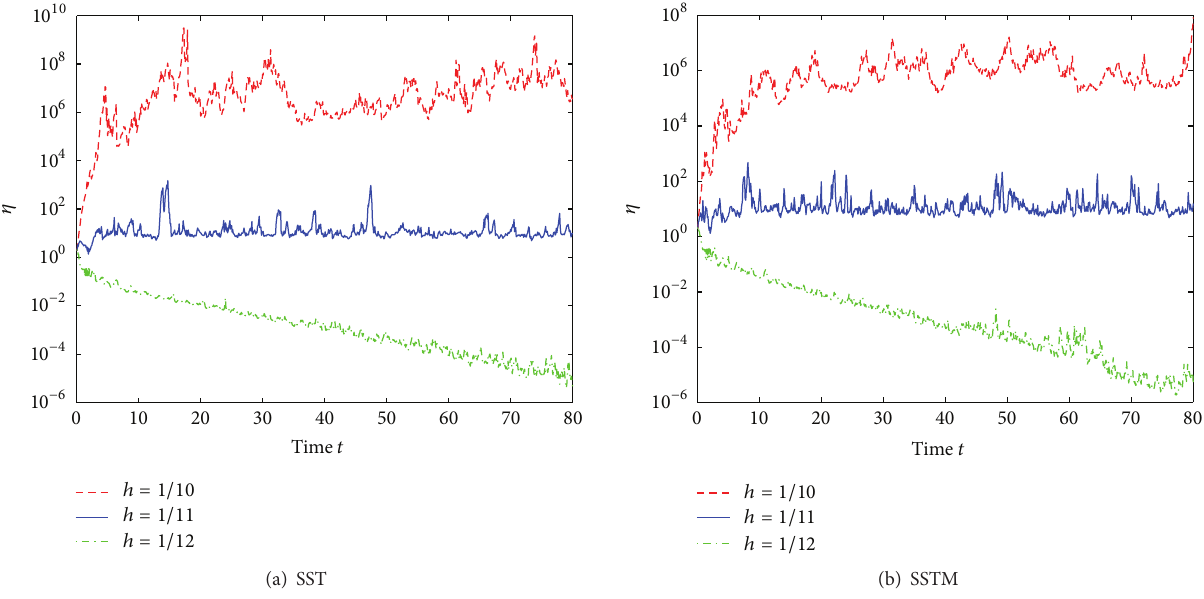
Figure 2: Mean-square stability comparison of SST and SSTM for the SDHNNs (43), Case 1, 𝜃 = 0 .